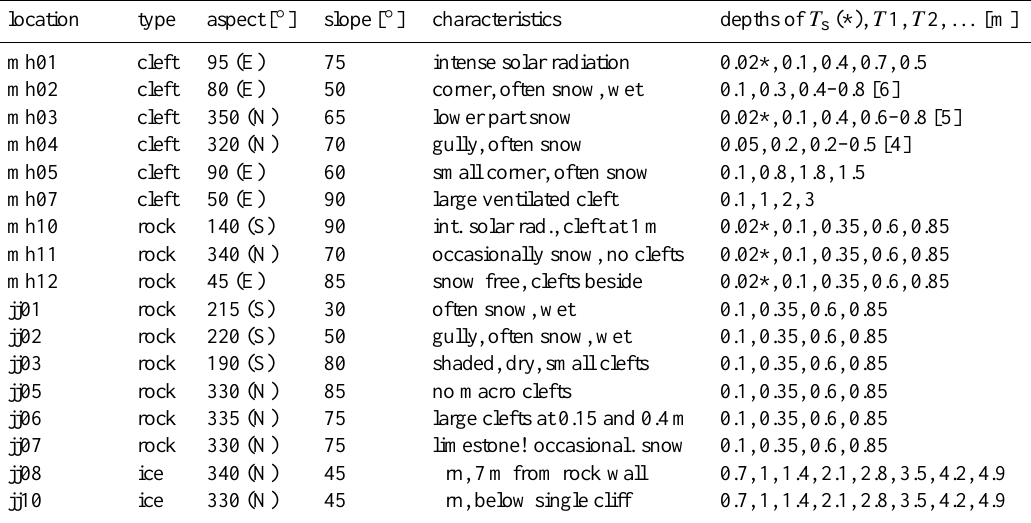
Table 1. Type and orientation of measurement locations with depth of the thermistors.